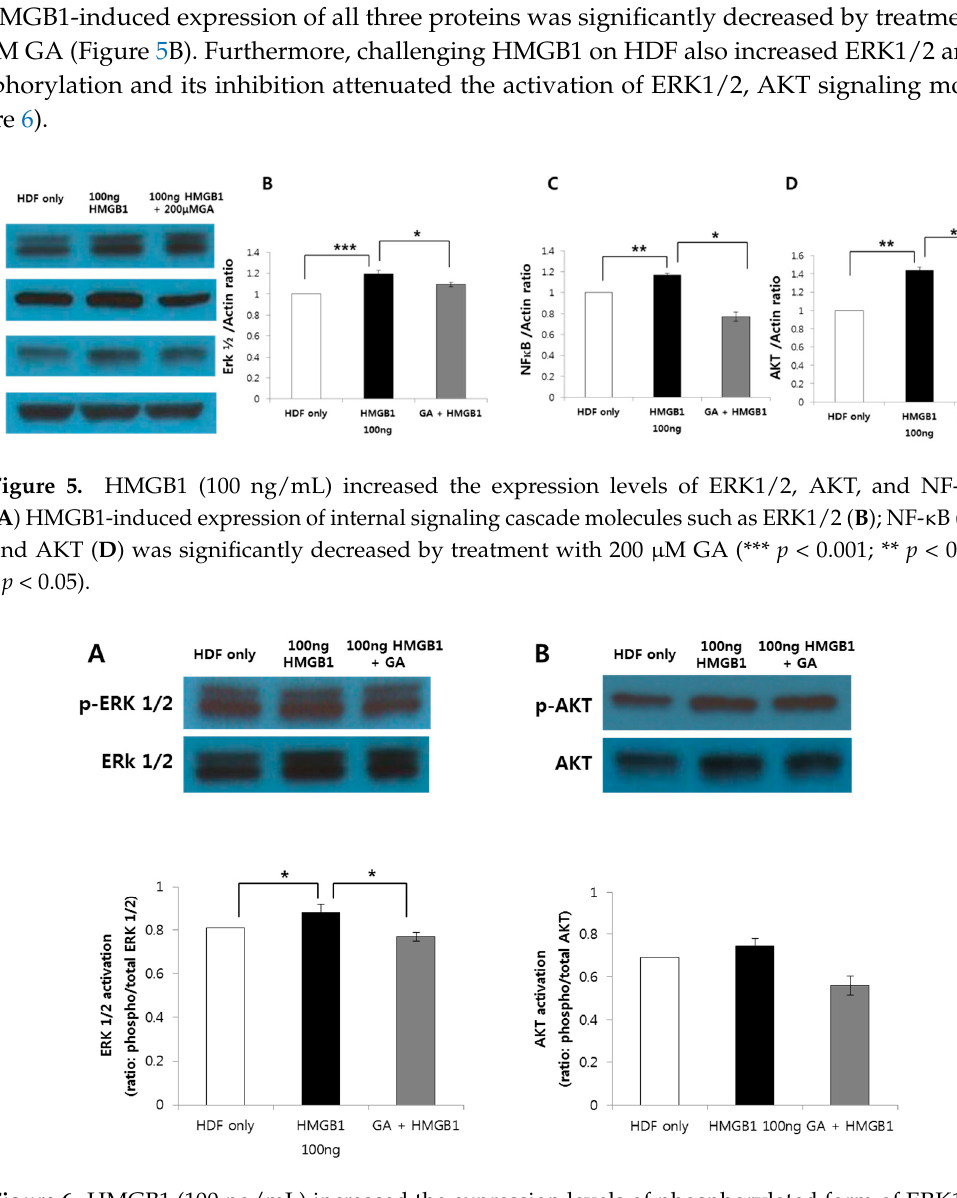
Figure 6. HMGB1 (100 ng/mL) increased the expression levels of phosphorylated form of ERK1/2 (p-ERK) and AKT (p-AKT). Assessment of both phosphorylated and total ERK1/2 ( A ) and AKT ( B ) was done to detect the activation of signaling cascade. The graph shows the ratio between the optical density of the bands of the phosphorylated form and the bands of the corresponding total protein. HMGB1-induced increase of p-ERK1/2 and p-AKT was decreased by treatment with 200 μ M GA and the change was statistically significant in p-ERK1/2 (* p < 0.05).